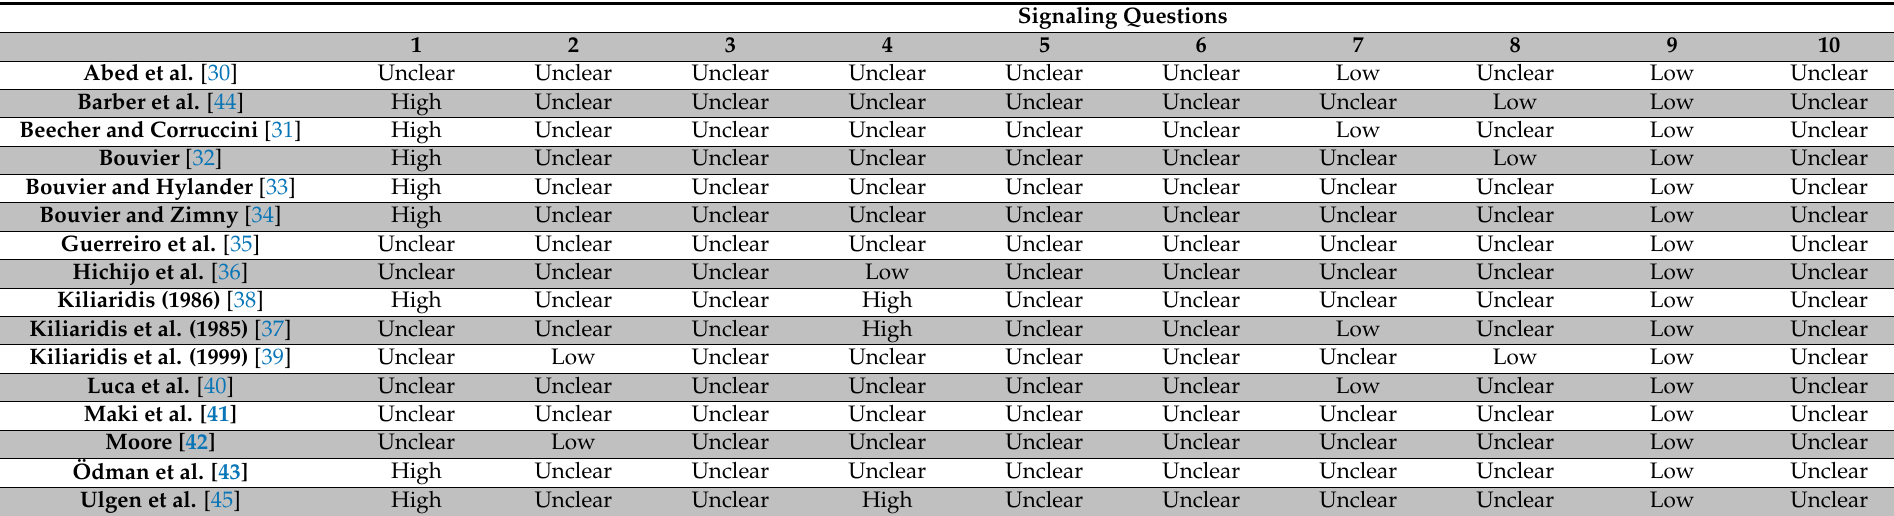
Table 2. Risk of Bias Assessment with